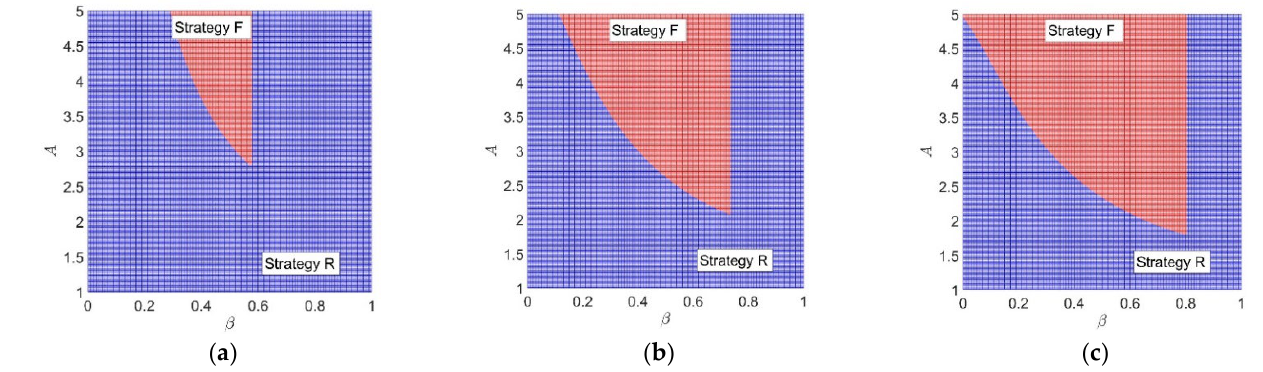
. ( a ) ; ( b ) ; ( c ) . . ( a ) 𝛿𝛿 = 0.2 𝑡𝑡 = 0 𝑡𝑡 = 0.1 𝑡𝑡 = 0.2 𝛿𝛿 = 0.2 𝑡𝑡 = 0